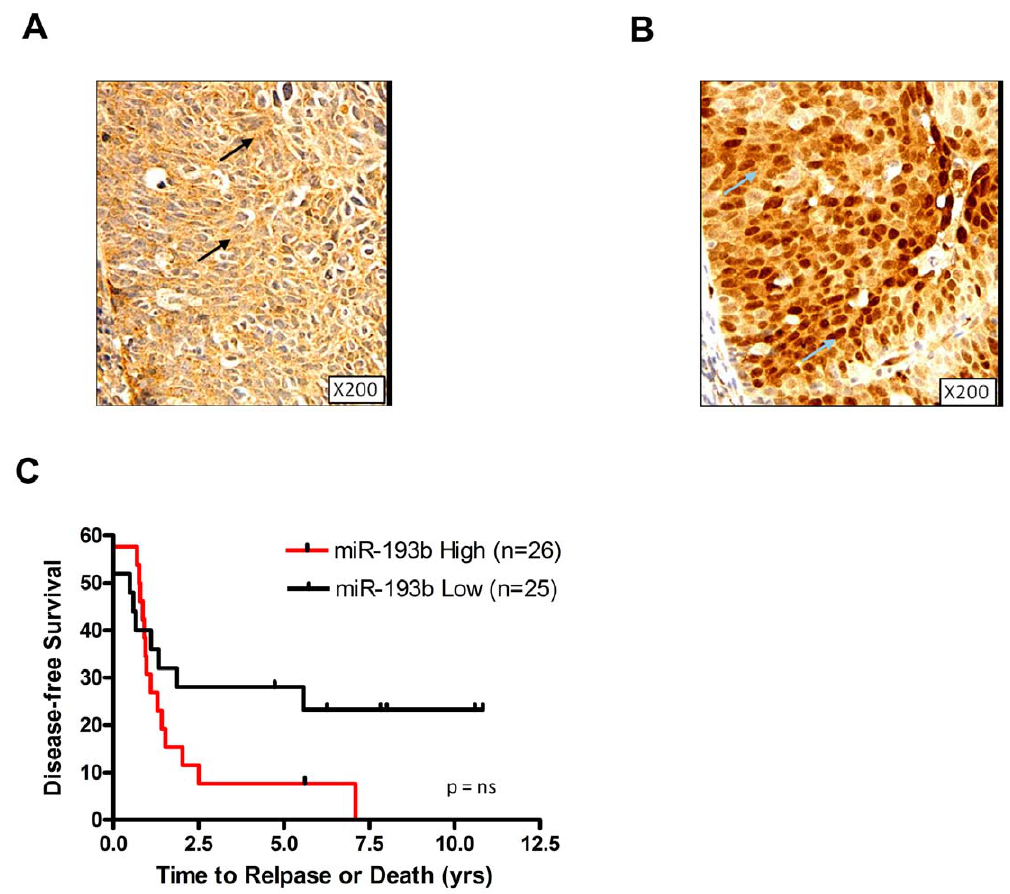
Figure 5. MiR-193b and p-ERK expression in a primary HNSCC patient sample. (A) A representative image of miR-193b in situ hybridization of a primary HNSCC biopsy, arrows indicating tumor cells exhibiting cytoplasmic signal. (B) A representative image of immunohistochemical analysis of p-ERK expression in the same patient’s HNSCC biopsy sample; arrows indicating expression in both the tumor nucleus and the cytoplasm. (C) Kaplan-Meier plots of disease free survival for HNSCC patients dichotomized based on high ( . median) vs . low ( # median) miR-193b expression. P=ns (not significant).